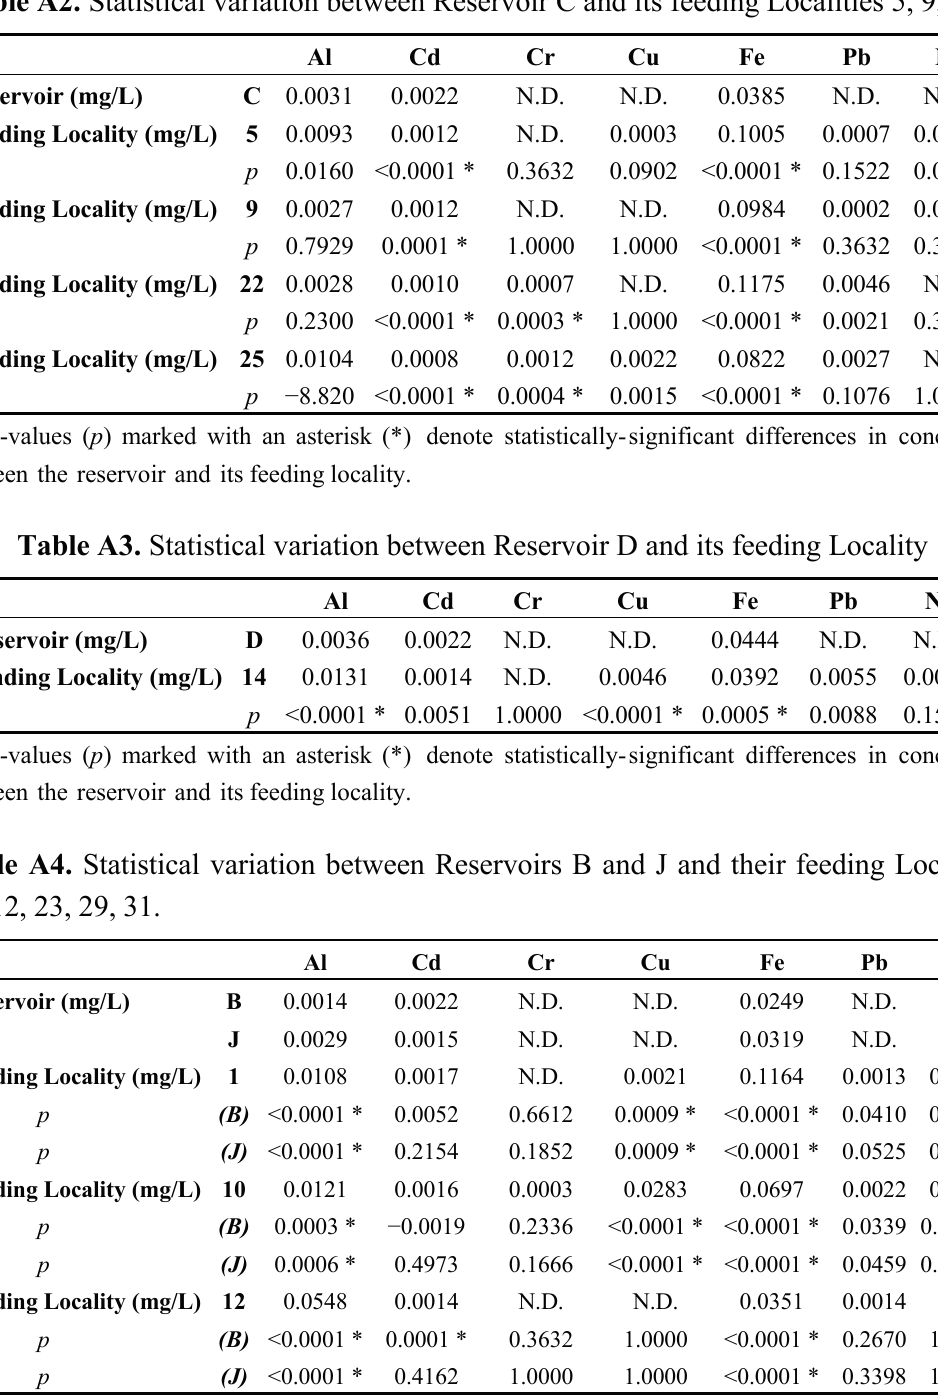
Table A2. Statistical variation between Reservoir C and its feeding Localities 5, 9, 22, 25.